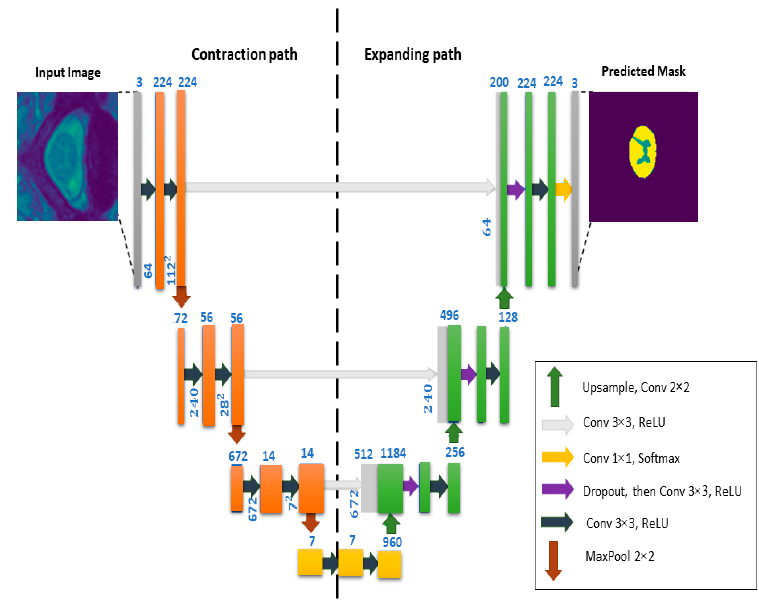
Figure 7. General overview of the architecture of the UNet model.